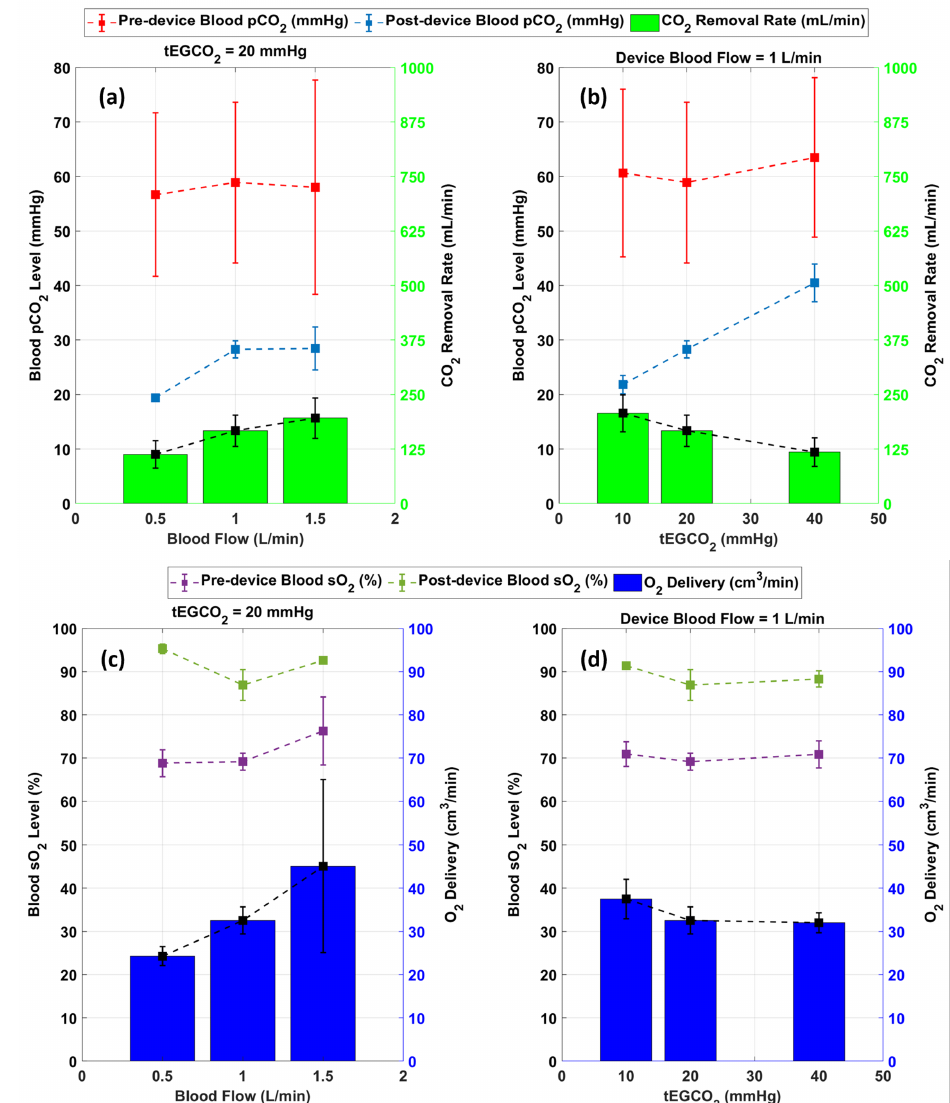
Figure 7. Result summary of in vitro studies showing ( a ) Effect of blood flow on CO 2 removal rate ( b ) effect of tEGCO 2 on CO 2 removal ( c ) O 2 delivery at various blood flows ( d ) O 2 delivery at various tEGCO 2 levels ( n =